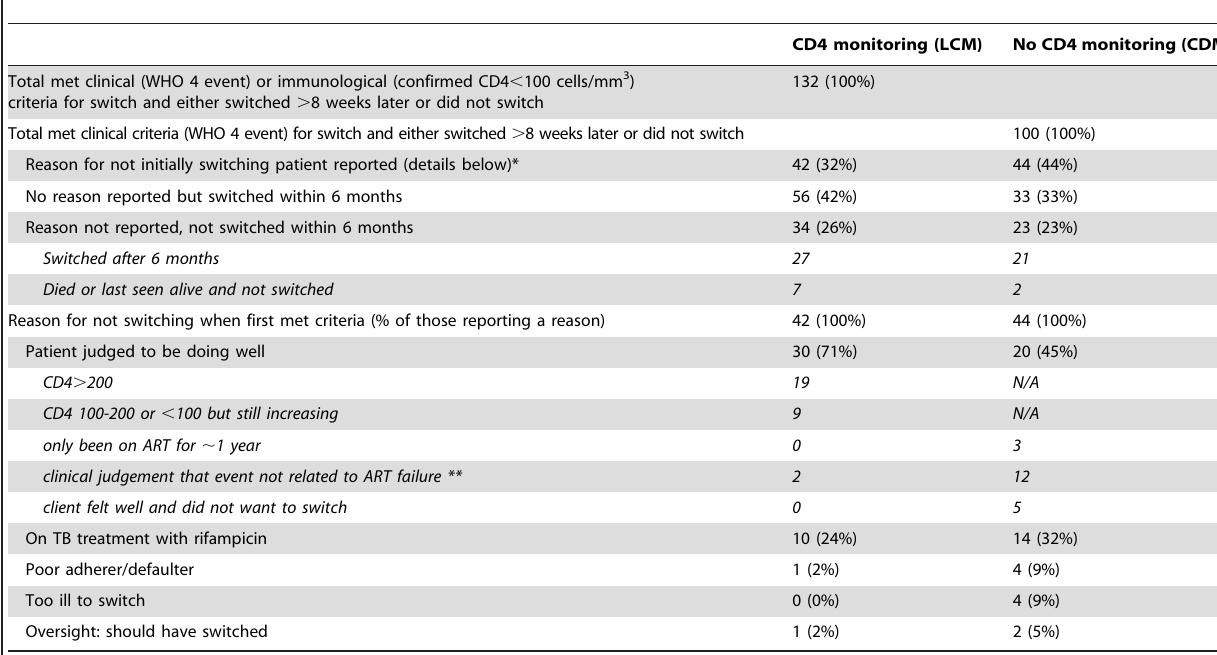
Table 1. Reasons for not switching when first met immunological/clinical criteria for switch in patients receiving and not receiving CD4